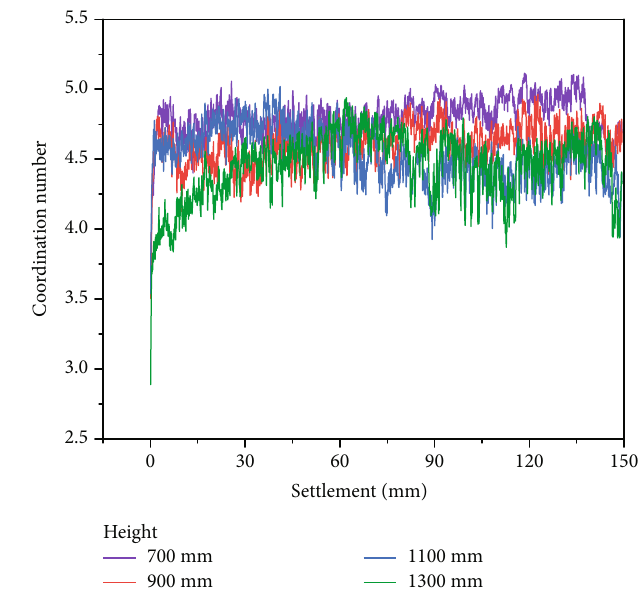
Figure 4: Vertical stresses of stone column under di ff erent settlements.